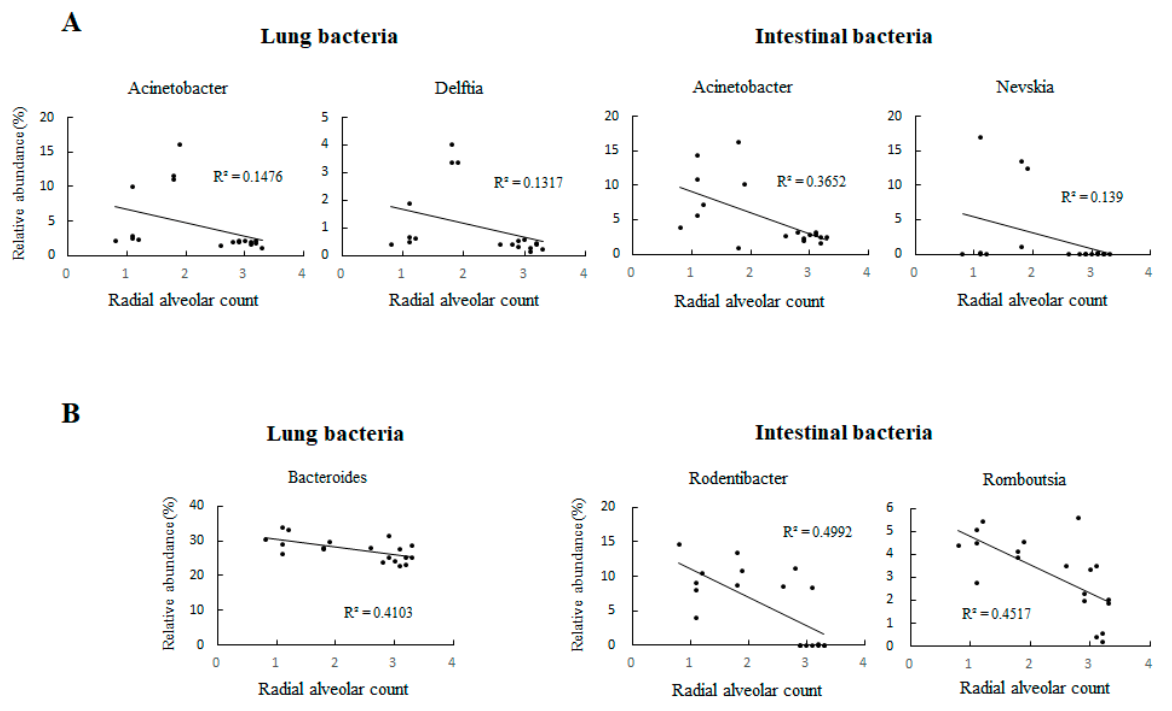
Figure 7. Correlations between lung and intestinal bacteria for which significant results were found at the genus level and the RAC on ( A ) postnatal day 0 and ( B ) postnatal day 7. On postnatal day 0, Acinetobacter and Delftia in the lungs and Acinetobacter and Nevskia in the gastrointestinal tract were significantly negatively correlated with the RAC ( p < 0.01). On postnatal day 7, Bacteroides in the lungs and Rodentibacter and Romboutsia in the gastrointestinal tract were significantly negatively correlated with the RAC ( p < 0.01). n = 8–10 rats at each postnatal day.